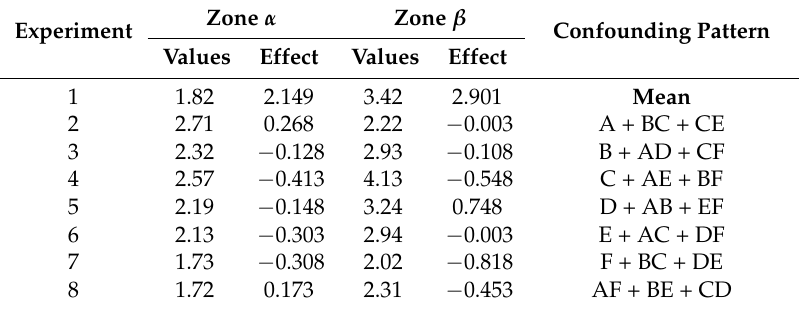
Table 6. Average values and standardized effects for the volume fraction of precipitated graphite ( V V ). Experiment